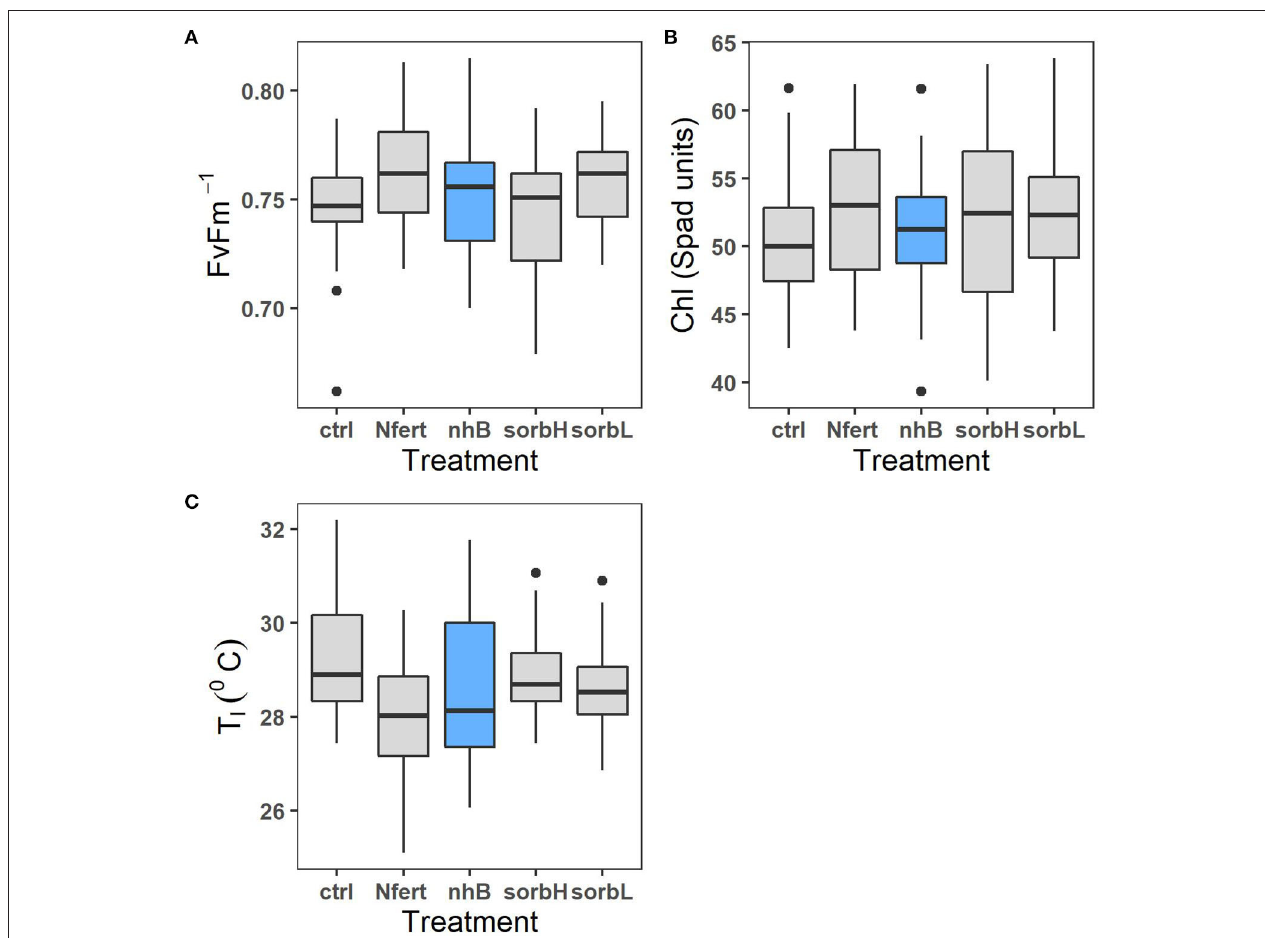
FIGURE 2 | Leaf physiological response of cowpea to osmotic treatments (sorbL, sorbH, and nhB) and N fertilizer treatment (Nfert). Plots represent chlorophyll fluorescence ratio (A) , leaf chlorophyll content (B) , and leaf temperature (C)